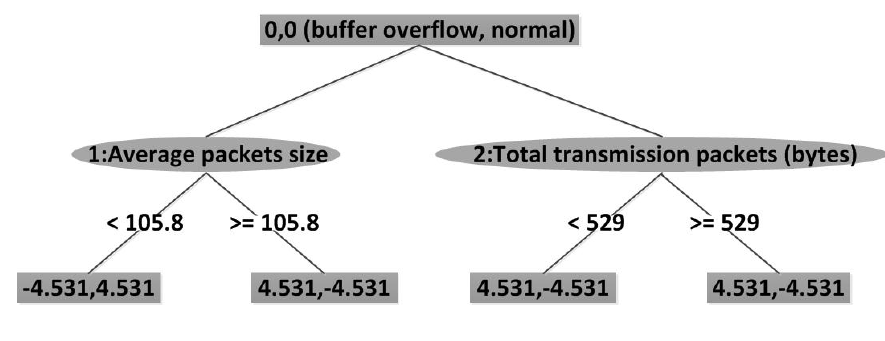
Figure 12. A result of LADTree.